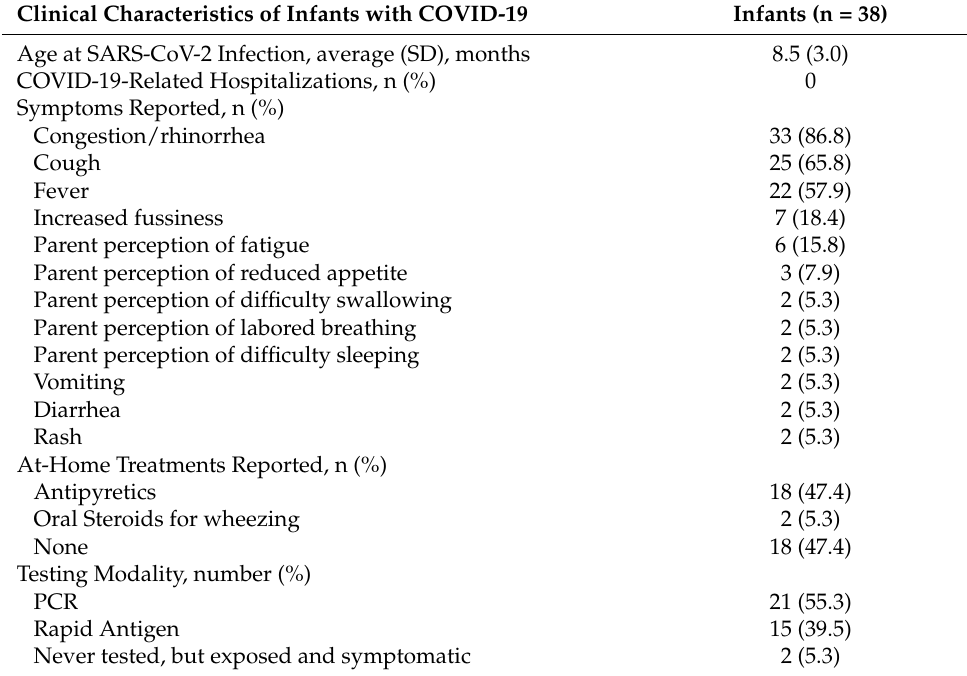
Table 2. Presentation and clinical outcomes of infants infected with SARS-CoV-2 who were born to individuals vaccinated in